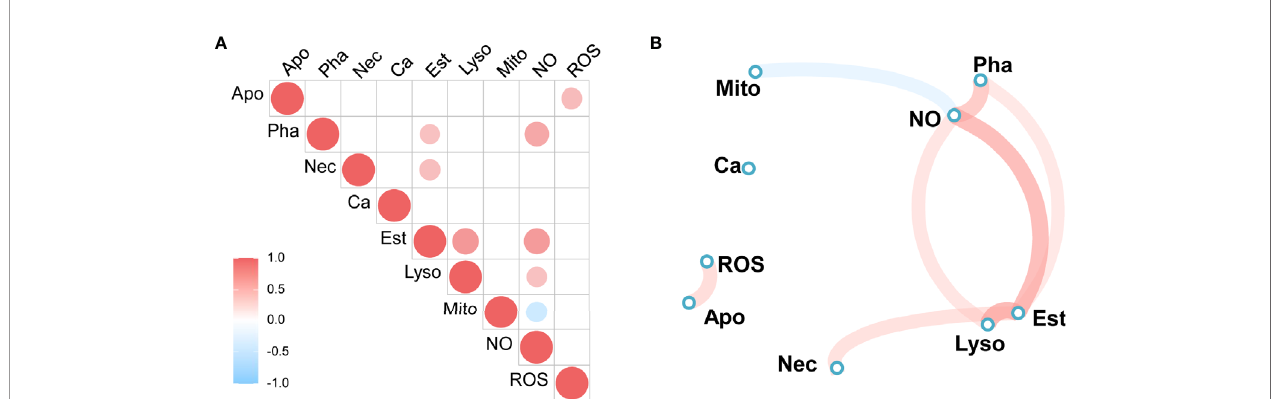
FIGURE 7 | Spearman ’ s correlation analysis of immune parameters. (A) Heatmap of correlation coef fi cients, (B) Correlation network diagram. Red to sky-blue represents positive to negative correlations. Mito, mitochondrial mass; NO, NO level; Ca, calcium content, Pha, phagocytic ratio; Est, esterase activity; ROS, ROS level; Lyso, lysosome mass; Apo, early apoptotic ratio; Nec, late apoptotic or